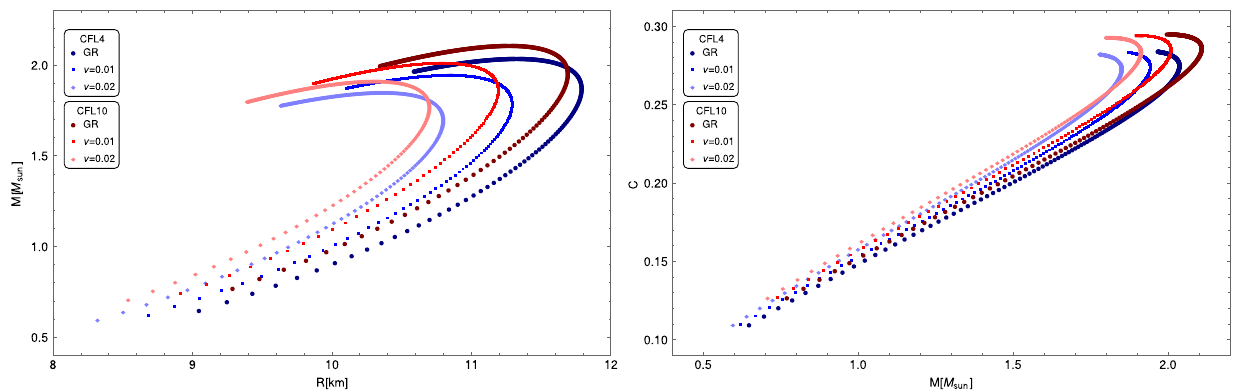
Fig. 1 Properties of strange quark stars with linear EoS. We have con- sidered 3 MIT bag models, SQSB40 (blue), SQSB56 (red) and SQSB60 (green) and ν = 0 . 01 , 0 . 02. The curves corresponding to GR ( ν = 0)